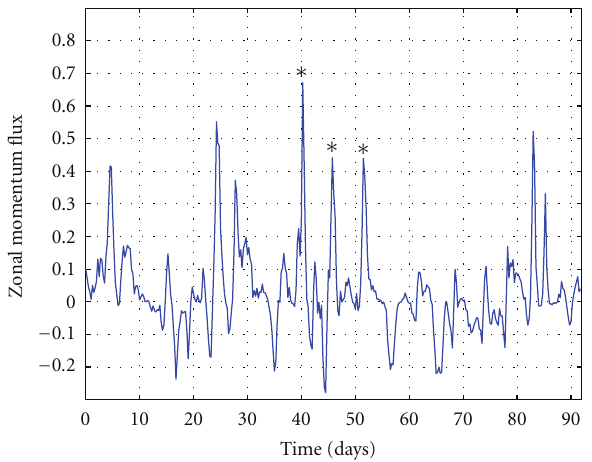
Figure 5: Meridional momentum flux from NCEP/NCAR Reanal- ysis dataset at 50 ◦ W, 36 ◦ S. The stars highlight the three consecutive strong fronts that reached the location on June 2008 for 10th, 16th, and